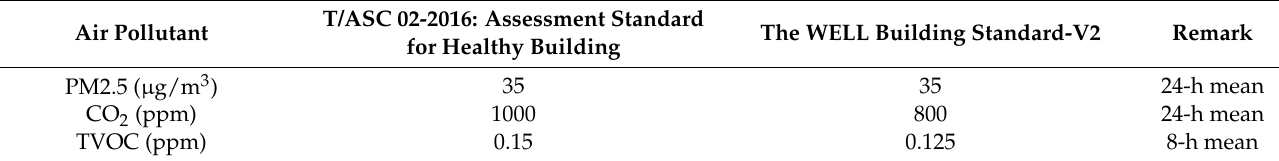
Figure 6. Temporal trends of wind velocity and air pollutants. Table 7. Air pollutant thresholds in healthy building standards.